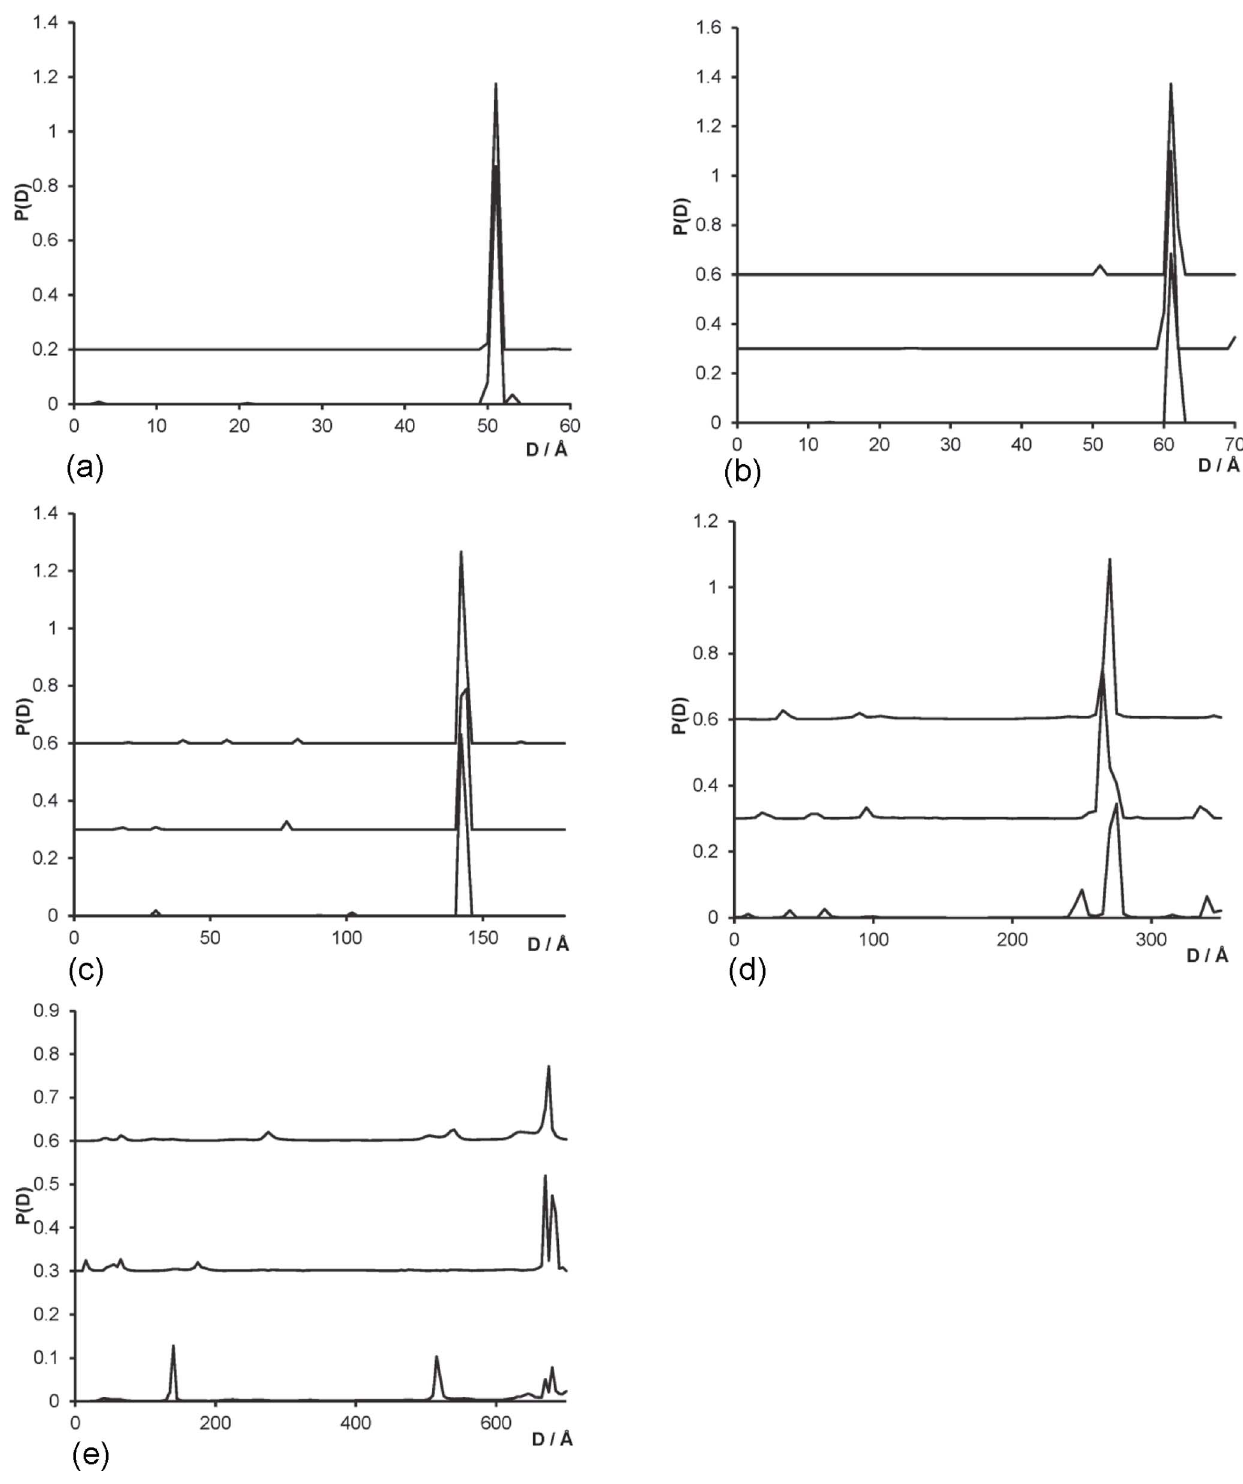
Figure 3. Results for label-label distance distribution P ( D ) of gold nanocrystals. (a) 10 bp DNA (b) 20 bp DNA (c) 50 bp DNA (d) 100 bp DNA (e) 200 bp DNA. Consecutive result sets are independent simulation runs; these are shifted vertically for clarity. The results shown are for least squares, non negative fitting for (a)–(c) and for maximum entropy fit for (d)–(e). Errors were simulated at 0.01% I (0).